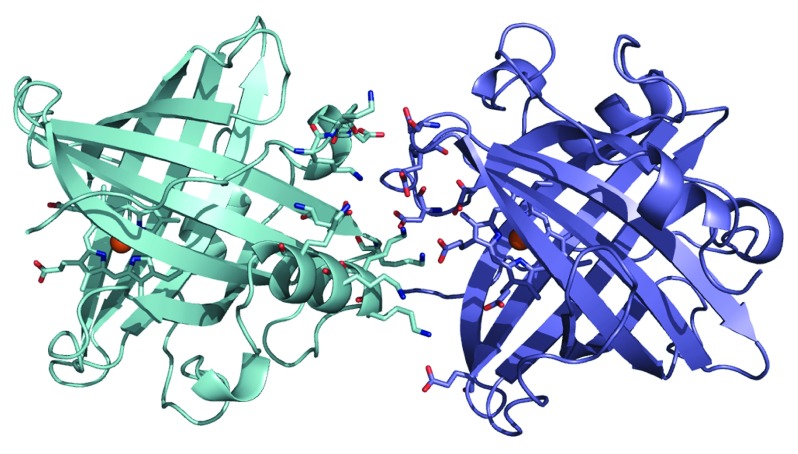
Distribution of positively and negatively charged residues in the head-to-tail interface between NP7 molecules.